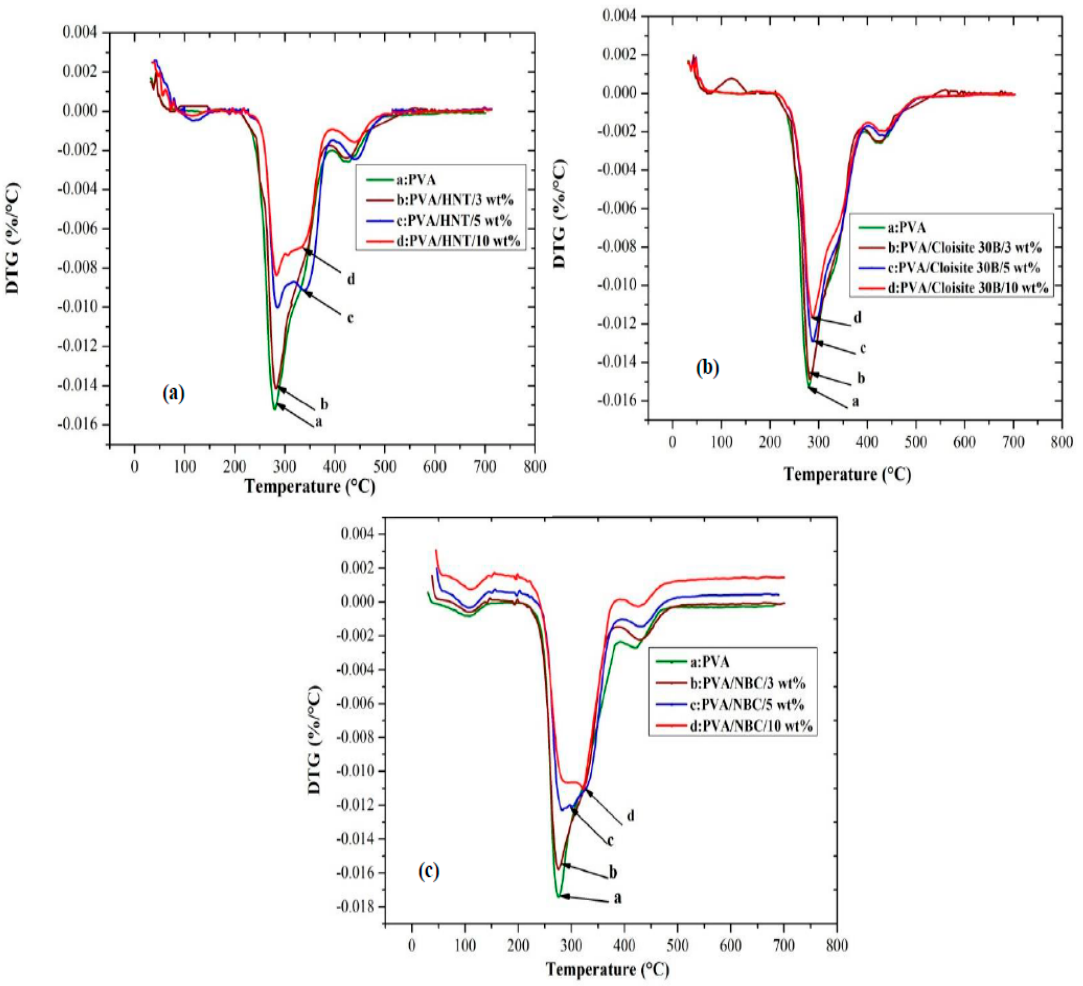
Figure 11. DTG curves for PVA bionanocomposites reinforced with ( a ) HNTs, ( b ) Cloisite 30B clays, and ( c ) NBCs.